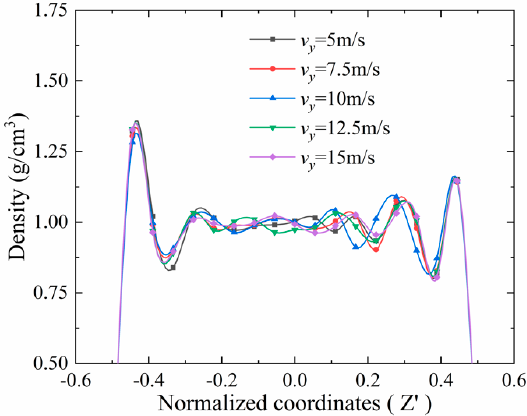
Figure 8. Density distribution of the film at different speeds ( h 0 = 6 nm, P = 1291MPa).